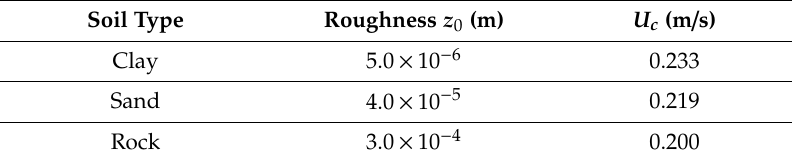
Table 4. Mean perpendicular current U c over cylinder